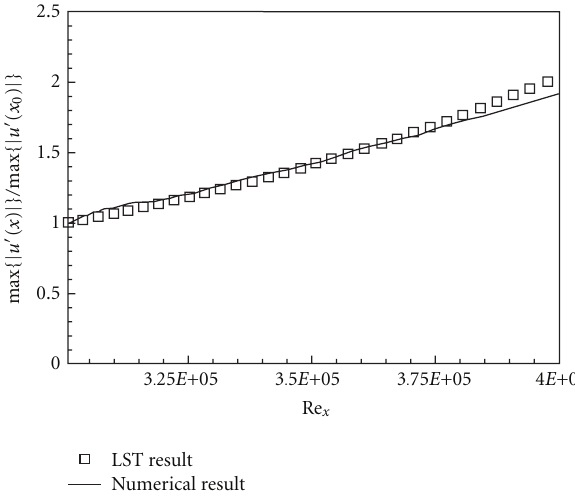
Figure 4: Comparison of the perturbation amplification rate between DNS and